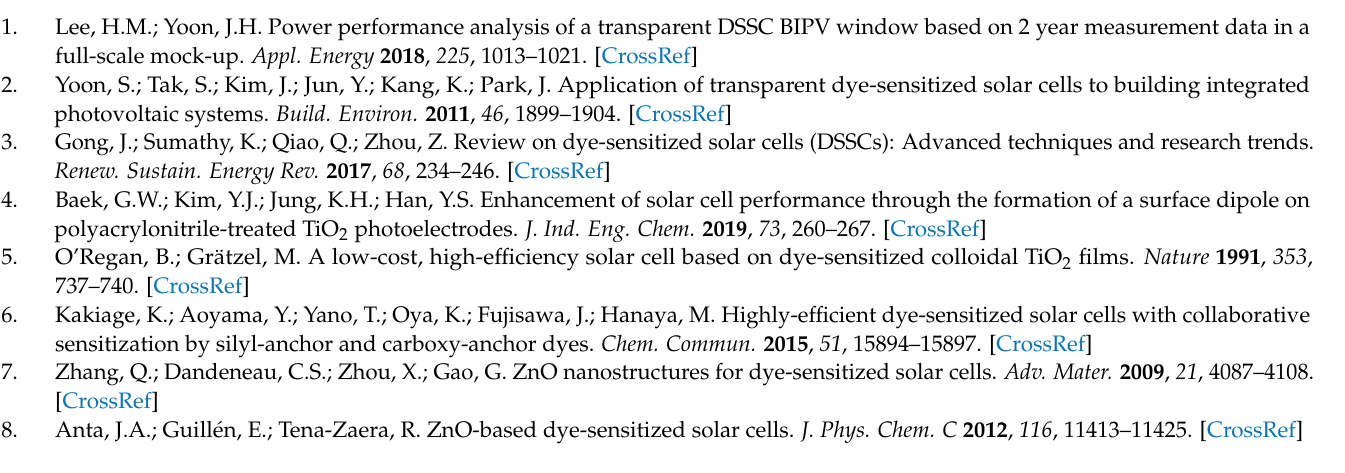
(b) of N719 dye. Ethanolic N719 solution was used for the absorption spectrum measurement, Figure S2: Schematic energy band diagram of ZnO-based DSC, Figure S3: SEM image (top view) of ZnO nanorods formed on a FTO glass, Figure S4. XRD pattern of ZnO nanorods formed on a FTO glass. Table S1: Averages and standard deviations of cell parameters, which were measured using 3–4 cells with ZnO nanorods, Table S2: Amounts of N719 dyes loaded on the surface of ZnO nanorods with growth time, Figure S5: XPS survey spectrum of Ag + (20)–ZnO/FTO electrode, Table S3: Averages and standard deviations of cell parameters, which were measured using 3–4 cells with the Ag + –ZnO/FTO electrodes, Table S4: Amounts of N719 dyes loaded on the surface of 8 h- grown ZnO nanorods with deposition time of silver ions, Figure S6: EDS spectra of (a) as-prepared and (b) 720-h-soaked Ag + (20)-ZnO particles, Figure S7: SEM (left) and EDS mapping (right)